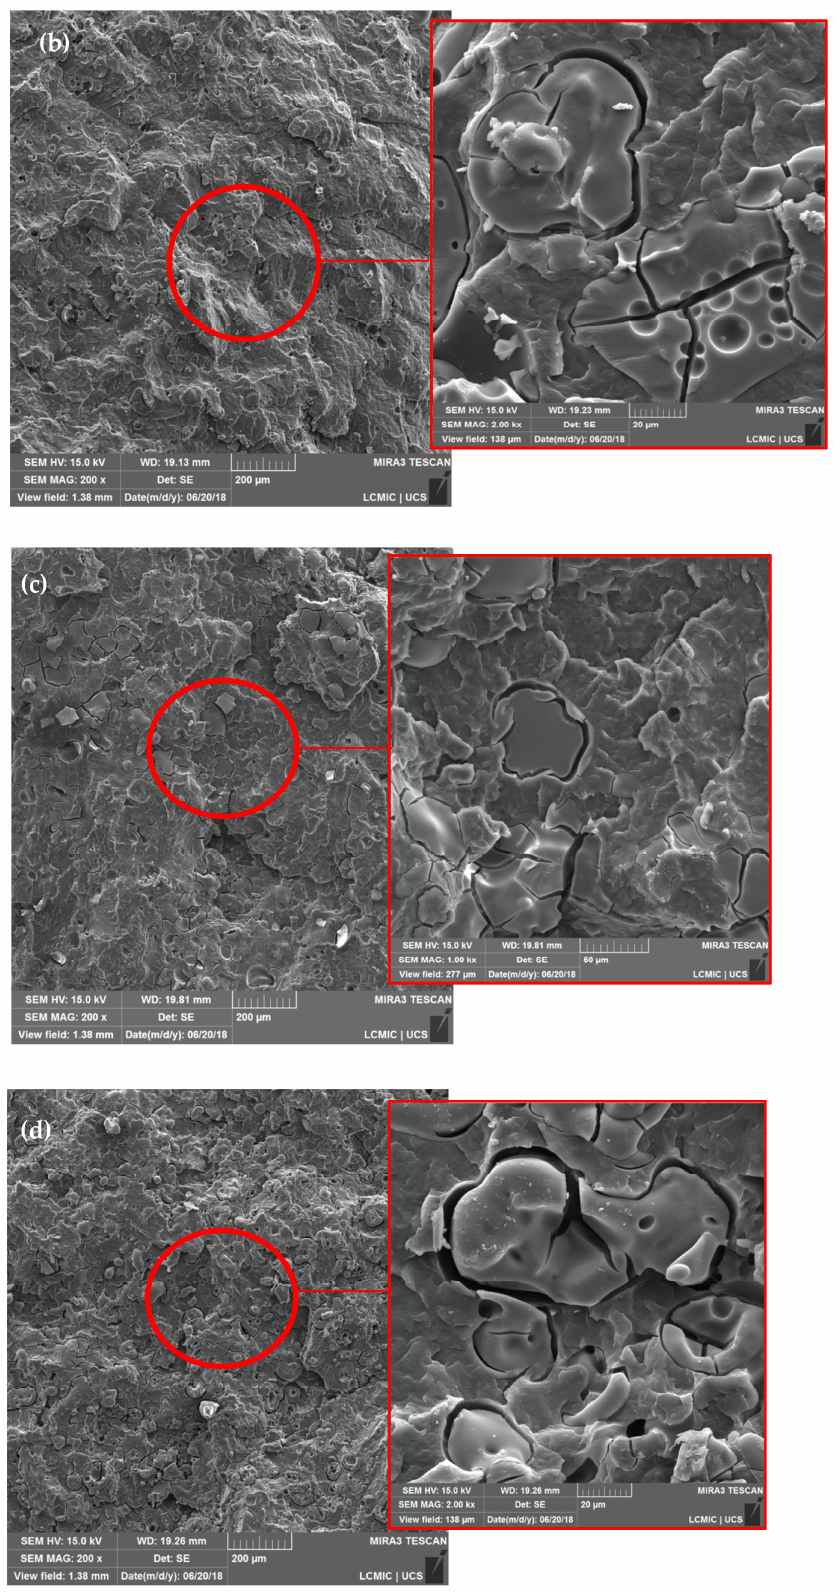
Figure 1. SEM micrographs of polypropylene/sodium lignosulfonate (PP/LGNa) blends with 10 ( a ), 20 ( b ), 30 ( c ), and 40 wt% ( d ) of LGNa with magnification of 200× and detail with magnification of 1000×.